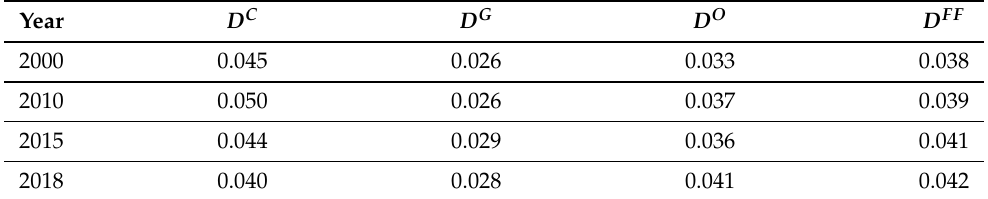
Table 3. The evolution of networks densities for coal, natural gas, oil, and fossil fuels networks.